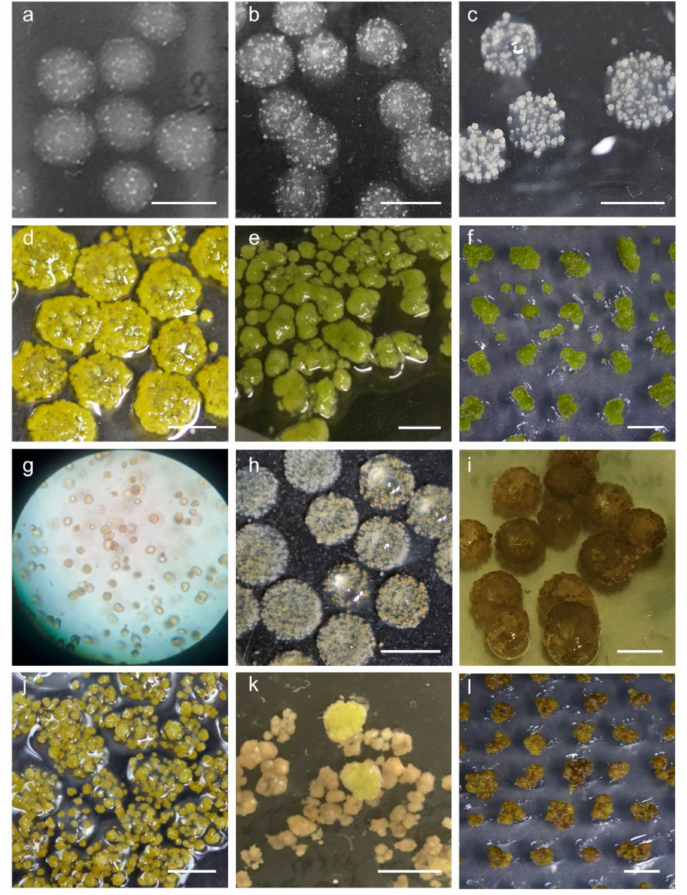
Figure 5. Images of microcallus induction to plant regeneration of potato protoplasts. ( a , b ) Initiation of microcalli from protoplasts in alginate lenses in CI medium for 2 weeks ( a ) and 3 weeks ( b ). ( c , d ) Development of minicalli in proliferation medium at 1 week ( c ) and 4 weeks ( d ). ( e ) Greening of alginate-released calli in G medium for 6 weeks. ( f ) Induction of regeneration of green calli in SI2 medium. ( g – l ) Conditions of calli for which the induction of plant regeneration from protoplasts is difficult. ( g ) Contaminated protoplasts. High-density protoplasts in an alginate lens. Development of minicalli from microcalli for 1 week ( h ) and 4 weeks ( i ) in P medium. ( j ) Low growth of minicalli in P medium for 4 weeks. ( k ) Low growth and greening of calli in SI1 medium for 6 weeks. ( l ) Browning of calli. Scale bar: 10